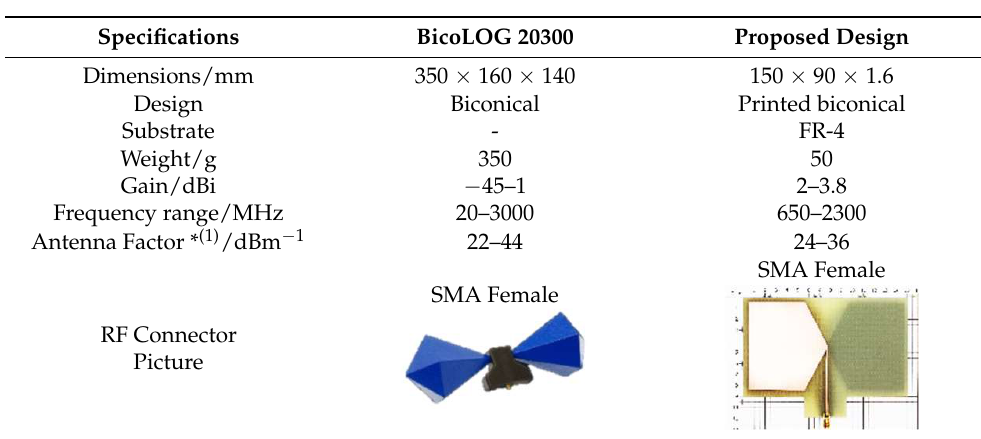
Table 3. Numerical comparison of antenna factor of the proposed antenna with the commercial antenna (BicoLOG 20300).